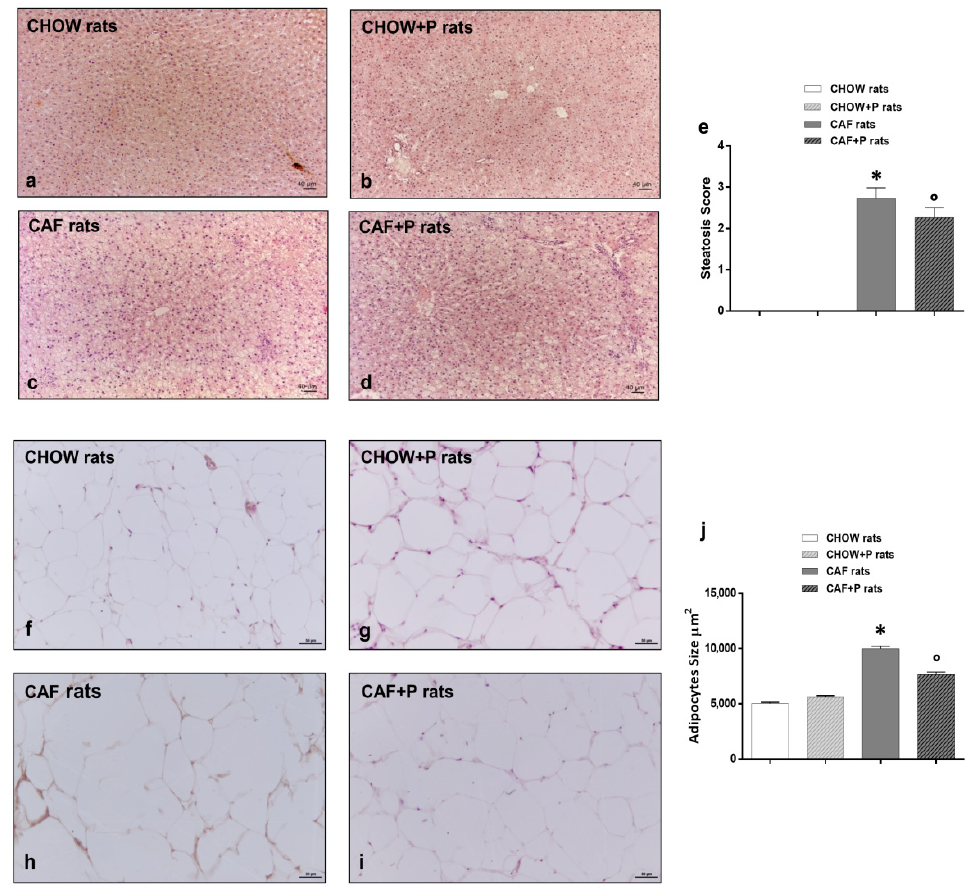
Figure 2. Hematoxylin and eosin (H&E) staining enhances the morphological features of liver ( a – d ) and visceral adipose tissue ( f – i ) of CHOW rats ( a , f ), CHOW+P rats ( b , g ), CAF rats ( c , h ) and CAF+P rats ( d , i ). The pictures of liver show normal structural organization and features, both for CHOW ( a ) and CHOW+P rats ( b ). On the contrary, liver sections from CAF rats show serious damages: largely extended areas of steatosis can be appreciated as well as the occurrence of inflammatory infiltrations. In CAF+P rats ( d ), the addition of the probiotic reduces the severity and extension of the steatotic condition. ( e ): the graph bar shows the score of steatosis, expressed as mean ± SEM. * p < 0.05 vs. CHOW, ° p < 0.05 vs. CAF. The pictures show an increase in the size of adipocytes area in CAF rats ( h ) compared to the CHOW ( f ) and CHOW+P ( g ) rats. The hypertrophy was counteracted in the CAF+P ( i ) rats. ( j ): the graph bar shows the size of adipocytes as mean ± SEM. * p < 0.05 vs. CHOW, ° p < 0.05 vs. CAF. Calibration bar ( a – d ): 40 µm. Calibration bar ( f – i ): 50 µm. CAF: cafeteria; P: probiotic supplementation.